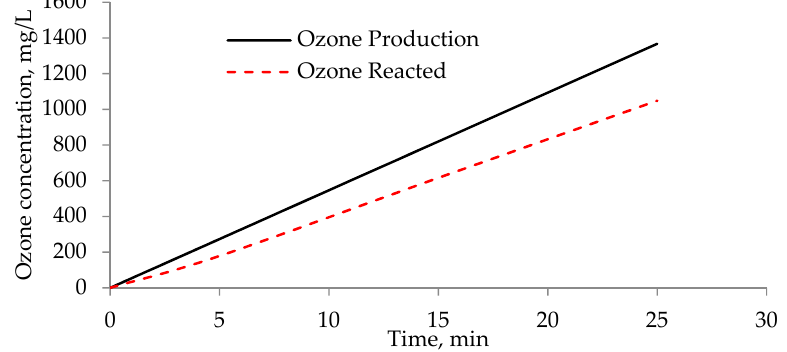
Figure 4. Ozone production and consumption rate in the ozone reactor. During the BPMED process, Ca 2+ and Mg 2+ cause calcification on the ion-exchange membrane surface and reduce the desalination efficiency of the BPMED process [31]. Re- moval of divalent cations is also essential while producing acid and base from wastewater due to reuse requirements in wet textile processes. Using ion-exchange resins for hard- ness removal from process water is a common practice in the textile sector. Regeneration wastewater of the softening process is the only hardness-causing source in textile wastew- ater as inorganic divalent ions are not used in wet textile processes. Once regeneration wastewater from softening process is mixed with textile wastewater, textile wastewater entering the biological treatment plant ends up containing hardness. Separation of soften- ing regeneration wastewater is merely an infrastructure issue and once it is carried out, hardness will cease to be an issue for any membrane treatment application, including